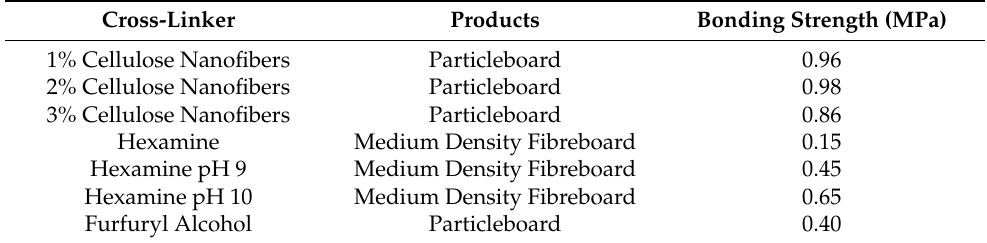
Table 4. Tannin-based NIPUs adhesives and their application in wood-based panels